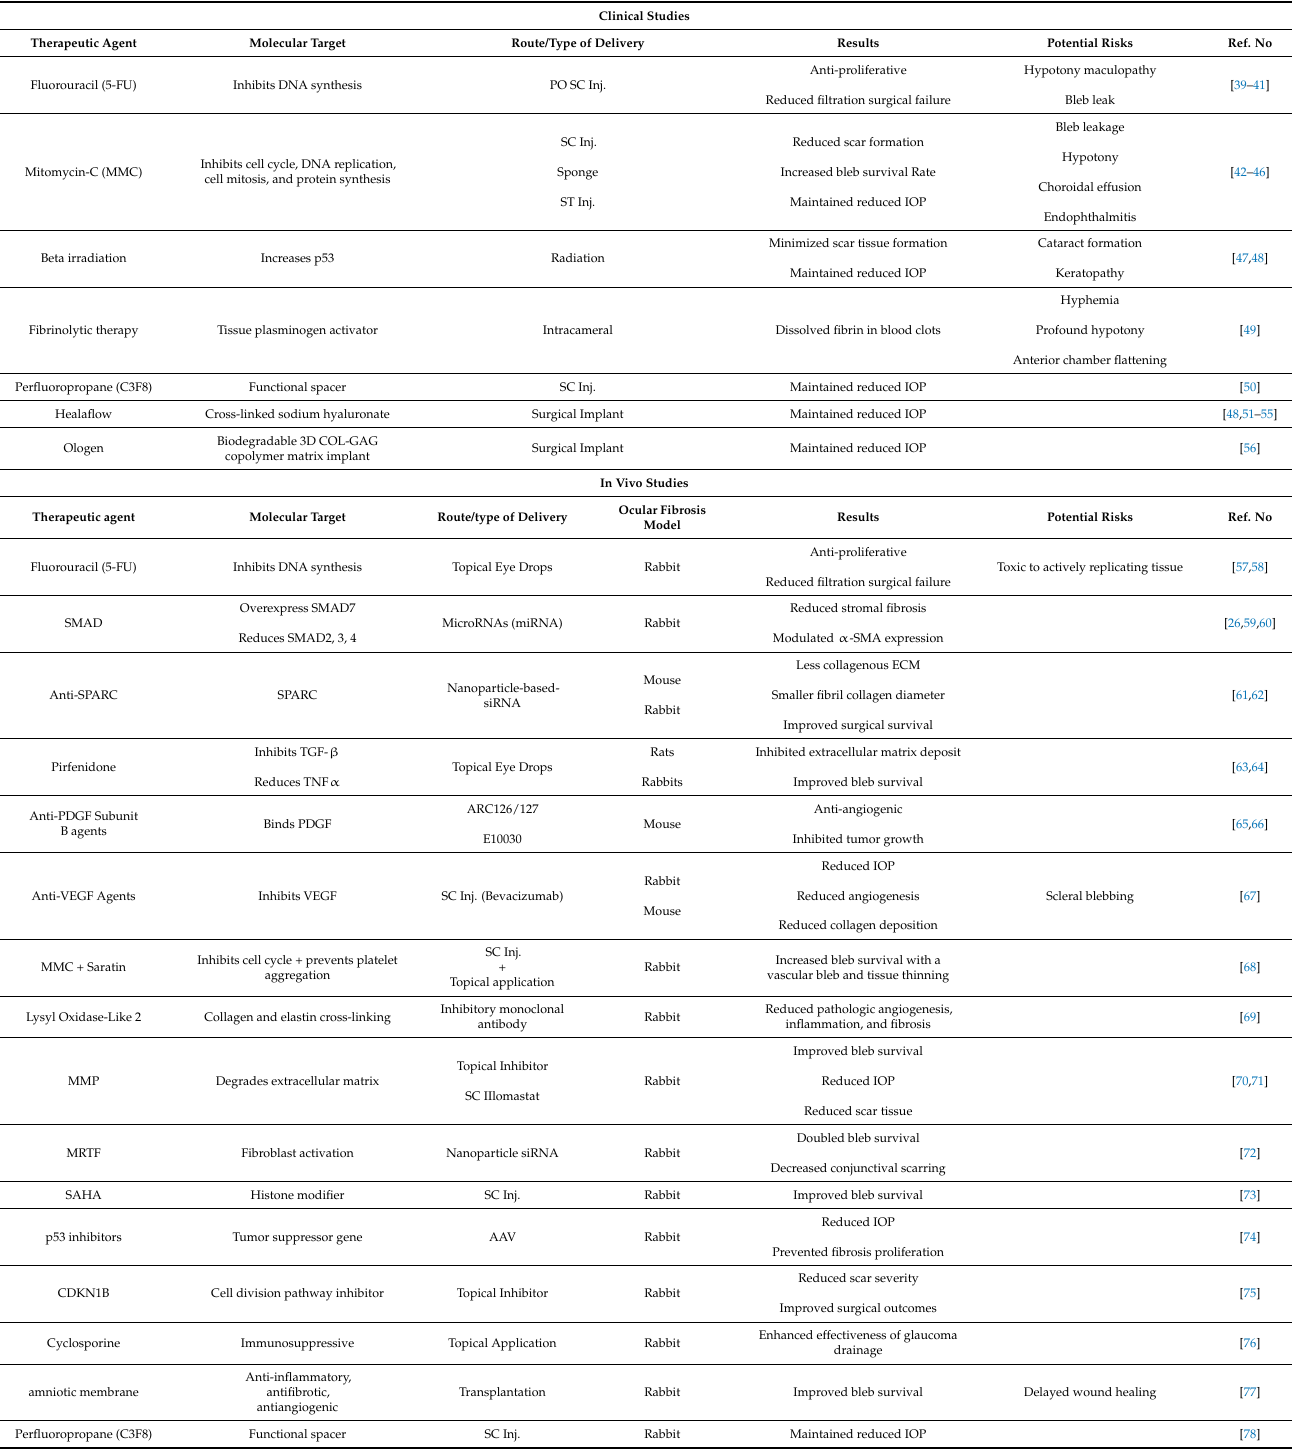
Table 1. Clinical, in vivo, and in vitro therapeutic agents and molecular targets for improving the success of glaucoma filtration